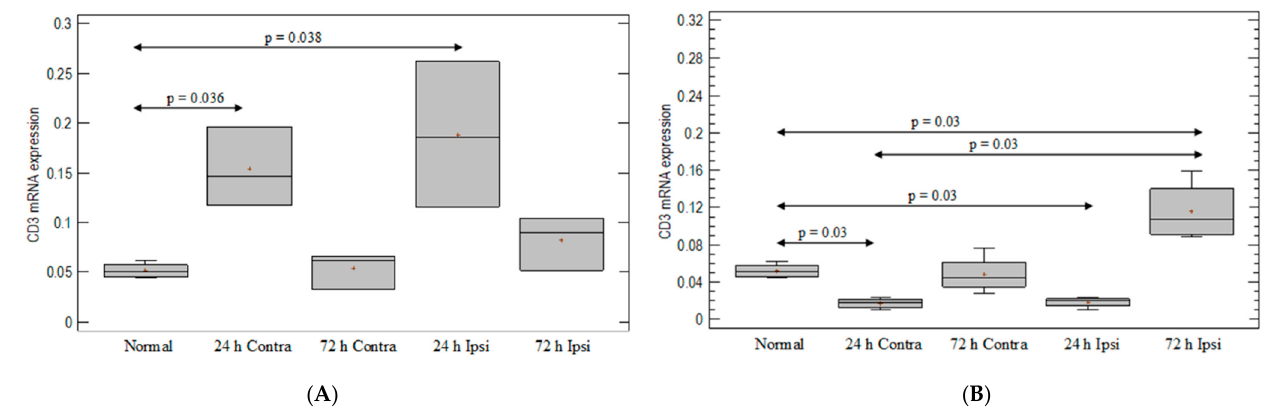
Figure 1. Expression of T-cell-line marker CD3 in mouse brain after ( A ) PBS injection and ( B ) KA injection. Brains were collected 24 h and 72 h postinjection. Ipsi—ipsilateral hemisphere; Contra— contralateral hemisphere; Normal—control animals without any injection.